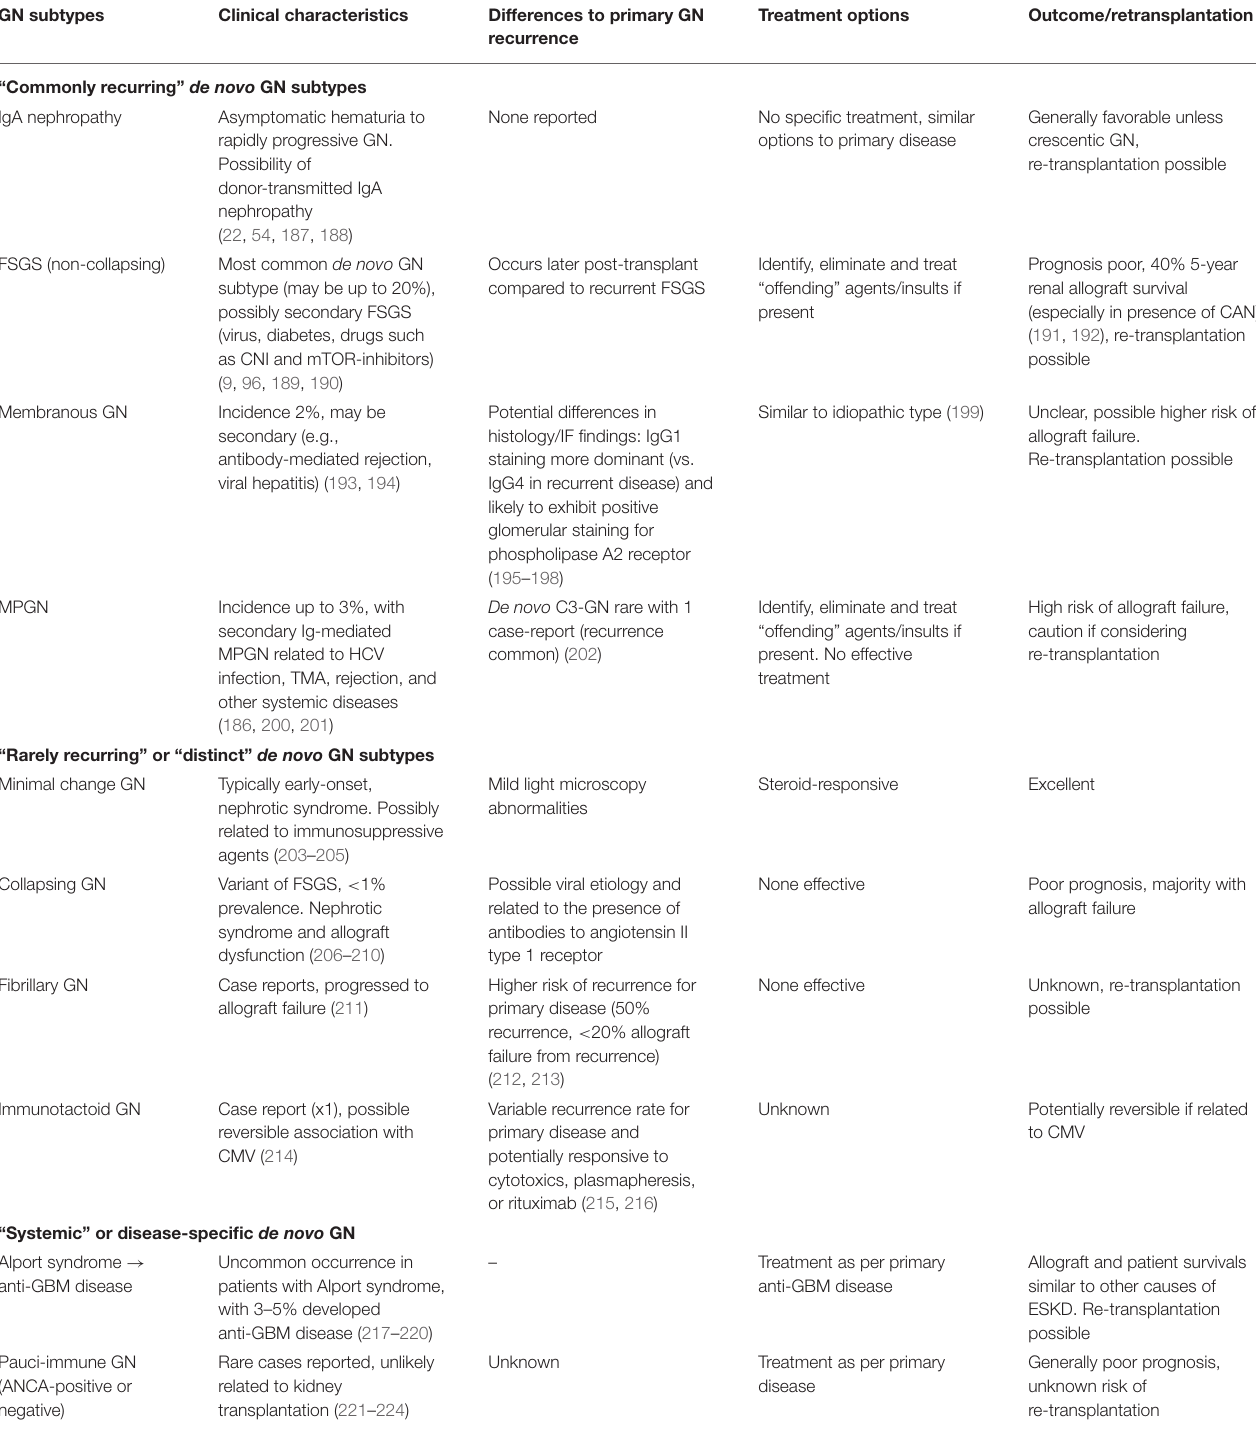
TABLE 4 | Characteristics and differences between de novo glomerulonephritis compared to recurrence of primary glomerulonephritis after kidney